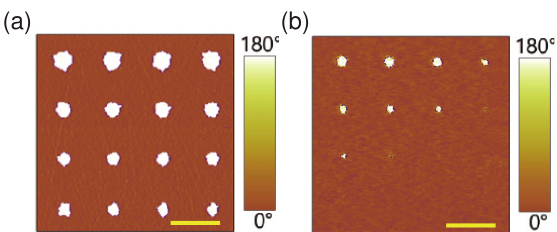
Figure 3. ( a ) PFM images of as-written dot domains with different diameters before the thermal annealing treatment. ( b ) The corresponding PFM images of dot domains after the thermal annealing treatment, at a temperature T = 120 ◦ C for 1 h. Here, the dot domains in each row were fabricated at the same AFM-tip voltage. These voltages were, from the bottom up, 40 V, 45 V, 50 V, and 55 V. The scale bar was 1 µ m in both cases.